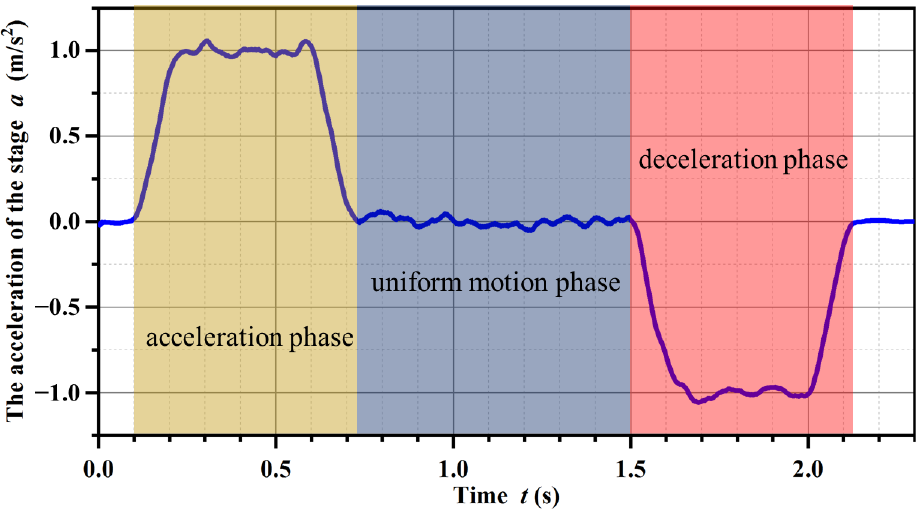
Figure 9. Acceleration of linear stage.